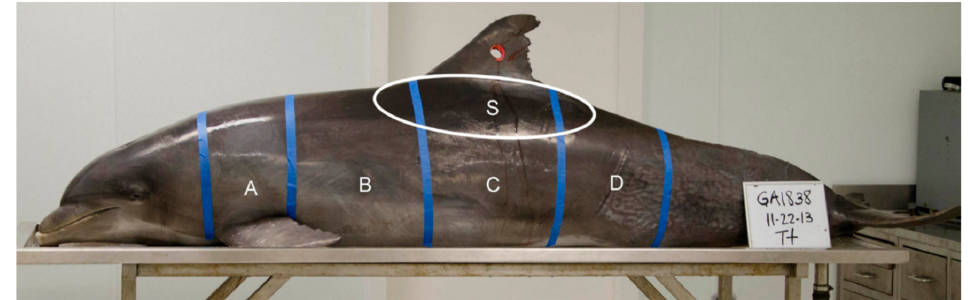
Figure 2. Grid partitions A, B, C, D, and S marked on an adult common bottlenose dolphin (GA1838) placed on a necropsy table. The hole in the dorsal fin was cut to use as a lifting point to hoist the dolphin onto the table with a crane.